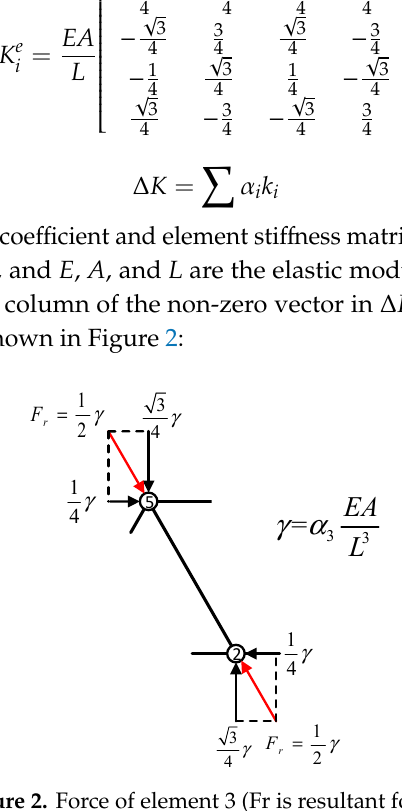
Figure 2. Force of element 3 (Fr is resultant force).